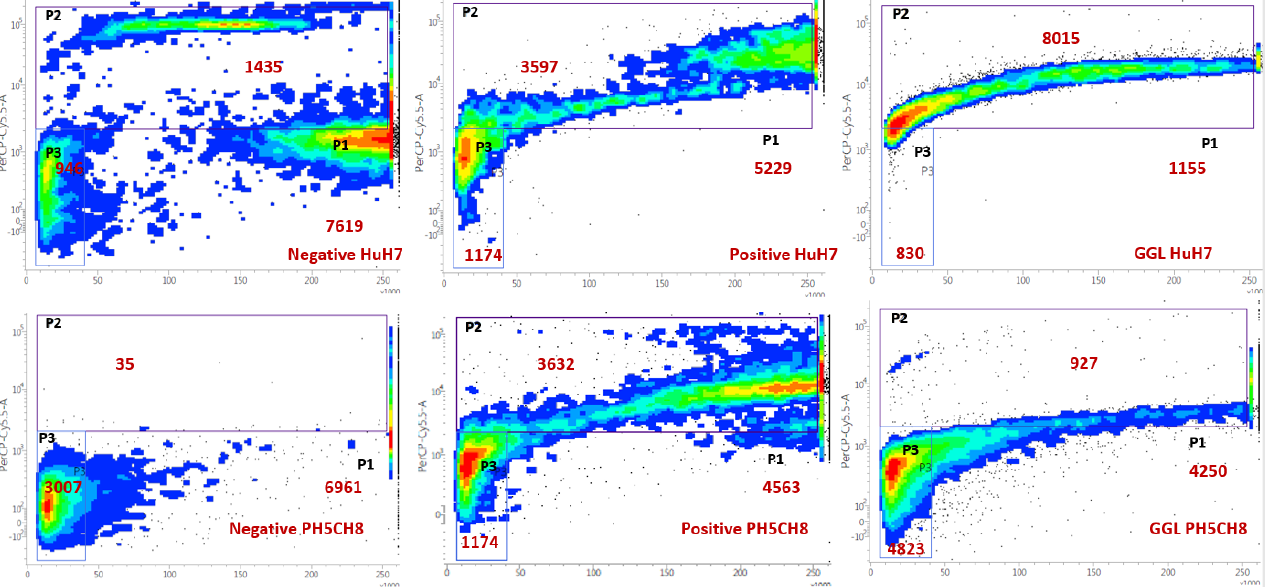
Figure 3. Flow cytometry image depicting cell viability of HeLa, HT29, HuH7 and PH5CH8 cells tested against negative and positive controls, and GGL extracts. The regions P1, P2 and P3 represent live cells, dead cells and debris, respectively.